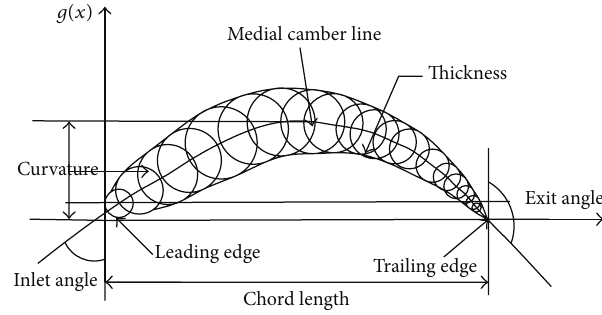
Figure 6: Parameters on the cross section.